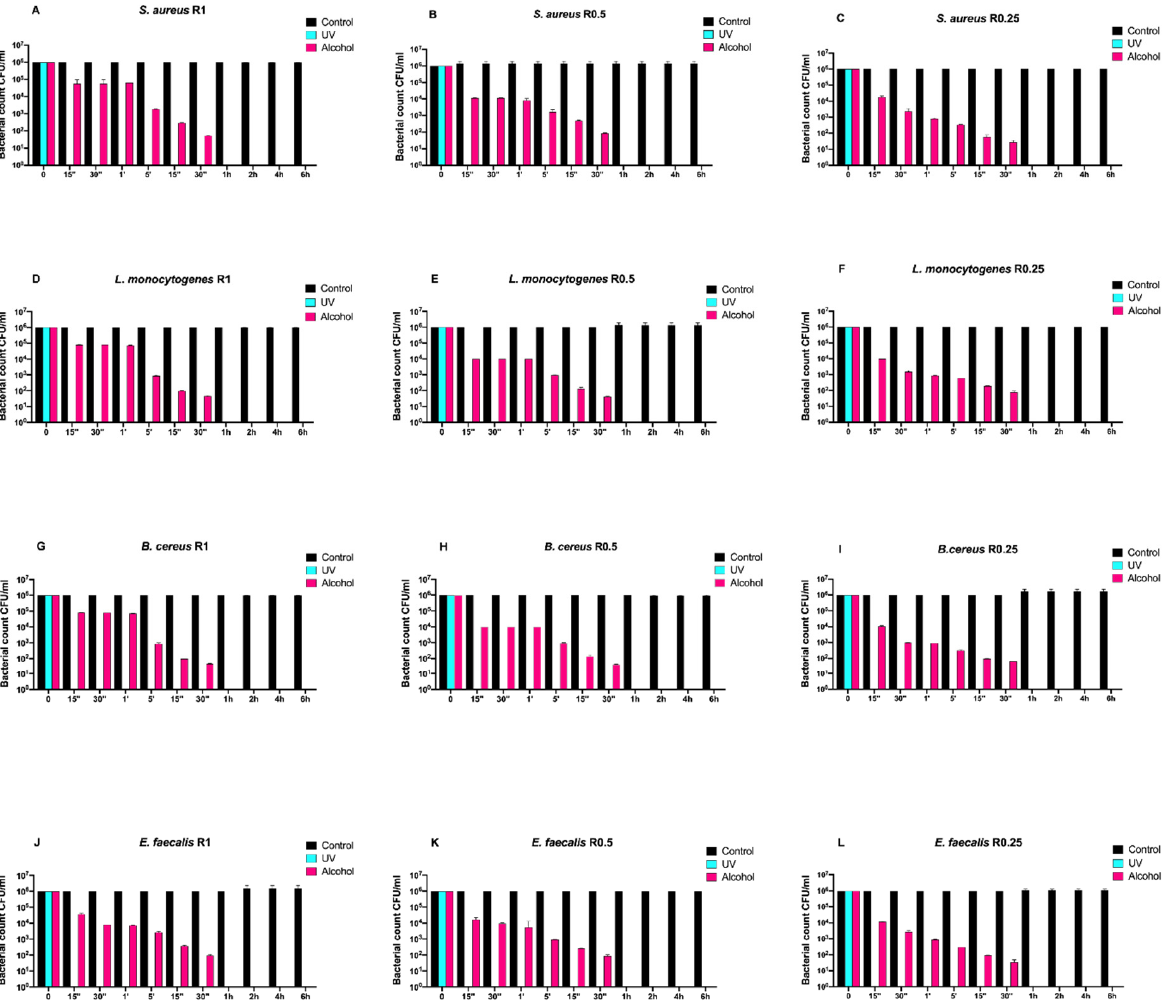
Figure 3. Graphical representation of the different exposure times of uncoated disks with different surface roughness (R0.25, R0.5, and R1) unsanitized (control) and subjected to two sanitizing methods (UVC and alcohol) against ( A – C ) Staphylococcus aureus ATCC 6538, ( D – F ) Listeria monocytogenes NCTT 10888, ( G – I ) Bacillus cereus ATCC 14579 and ( J – L ) Enterococcus faecalis ATCC 29212 .